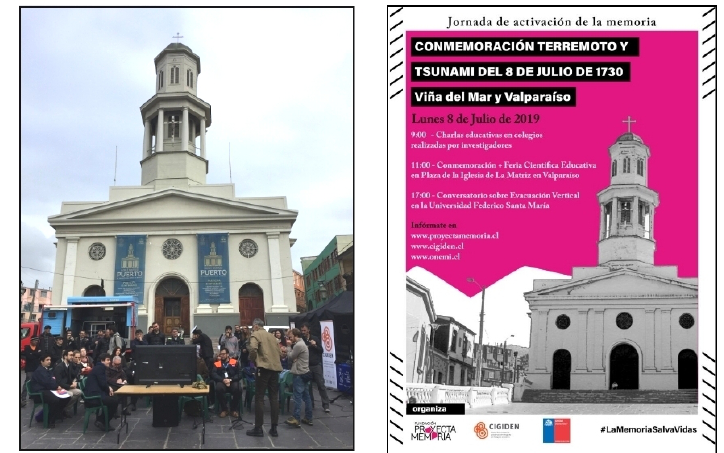
Figure 8. Authorities, students of the Santa Ana school, and the public attending the scientific talks (left panel). Invitation poster of the great 1730 Valparaíso earthquake and tsunami commemoration (right